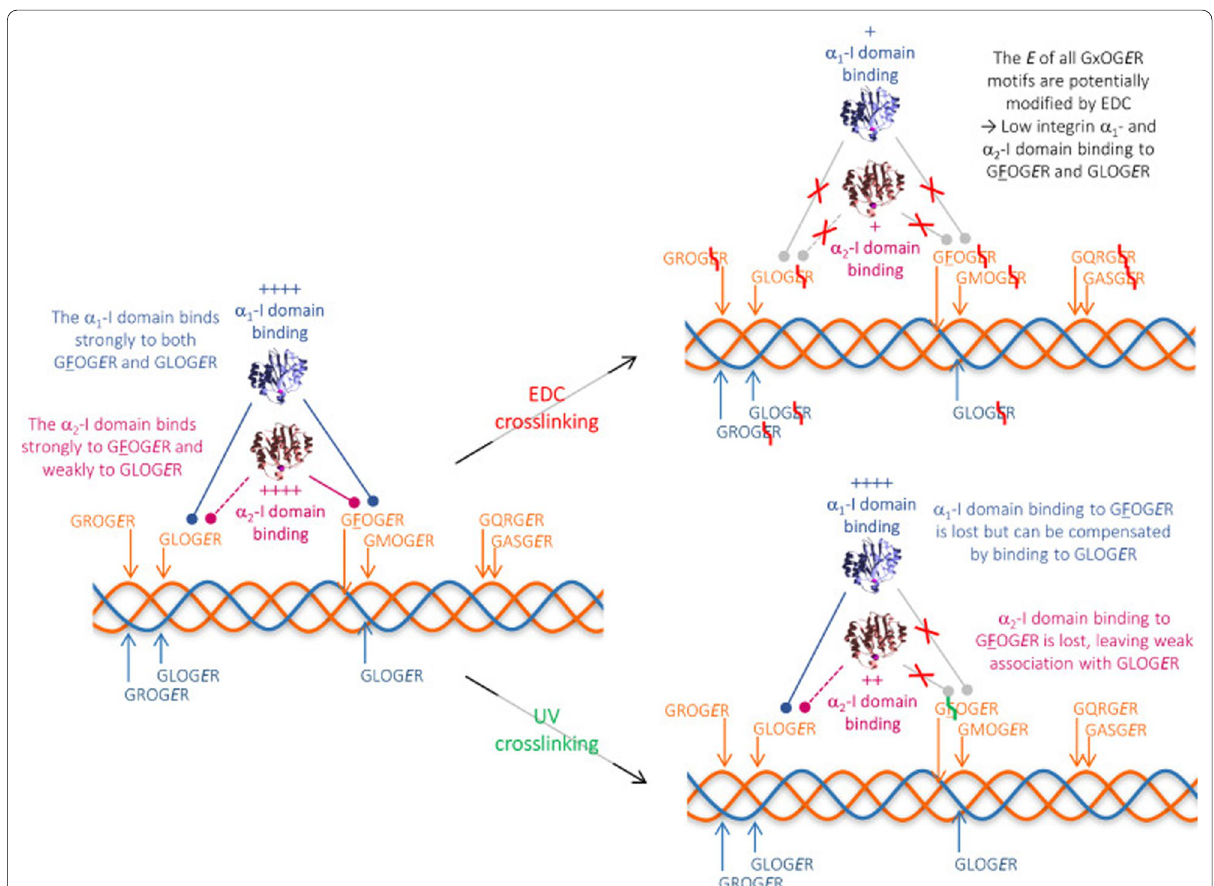
Fig. 4 Schematic representation showing the potential modification of integrin α1 (blue lines) and α2 (pink lines) binding sites on collagen I by EDC (red) or UV (green). The collagen α1(I) chain and binding sites are depicted in orange and the α2(I) chain and binding sites are in blue. , and above the integrin I-domain indicate strong, moderate and weak collagen binding, respectively. ( Adapted from ref. [49], + + + + + + + copyright 2019, with permission from the